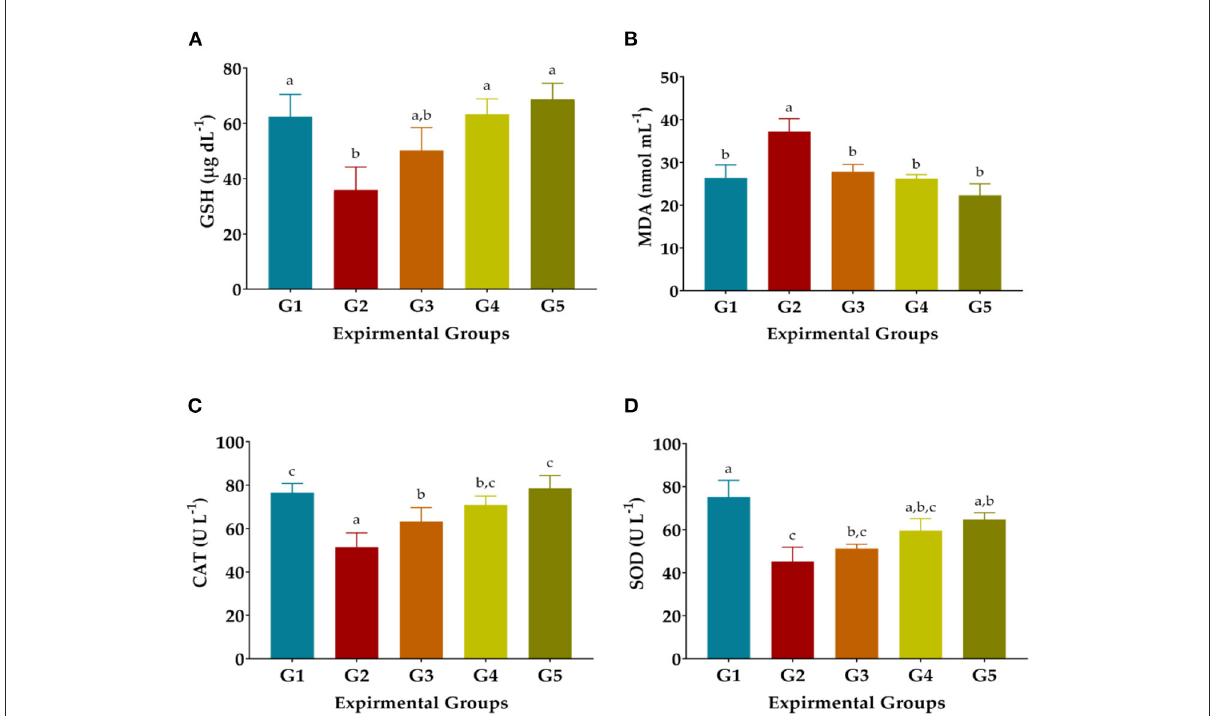
FIGURE2 Effects of oral administration of hydroalcoholic extract of L. culinaris sprouts on antioxidant biomarkers in CCl 4 -induced oxidative stress and hepatotoxicity in rats (mean ± SE), n = 8. (A) GSH: Reduced glutathione, (B) Malondialdehyde, (C) CAT: Catalase, and (D) SOD: Superoxide dismutase. G1–G5: Experimental groups see materials and methods, a,b,c,d : Bars not sharing similar letters are statistically different at p < 0.05.